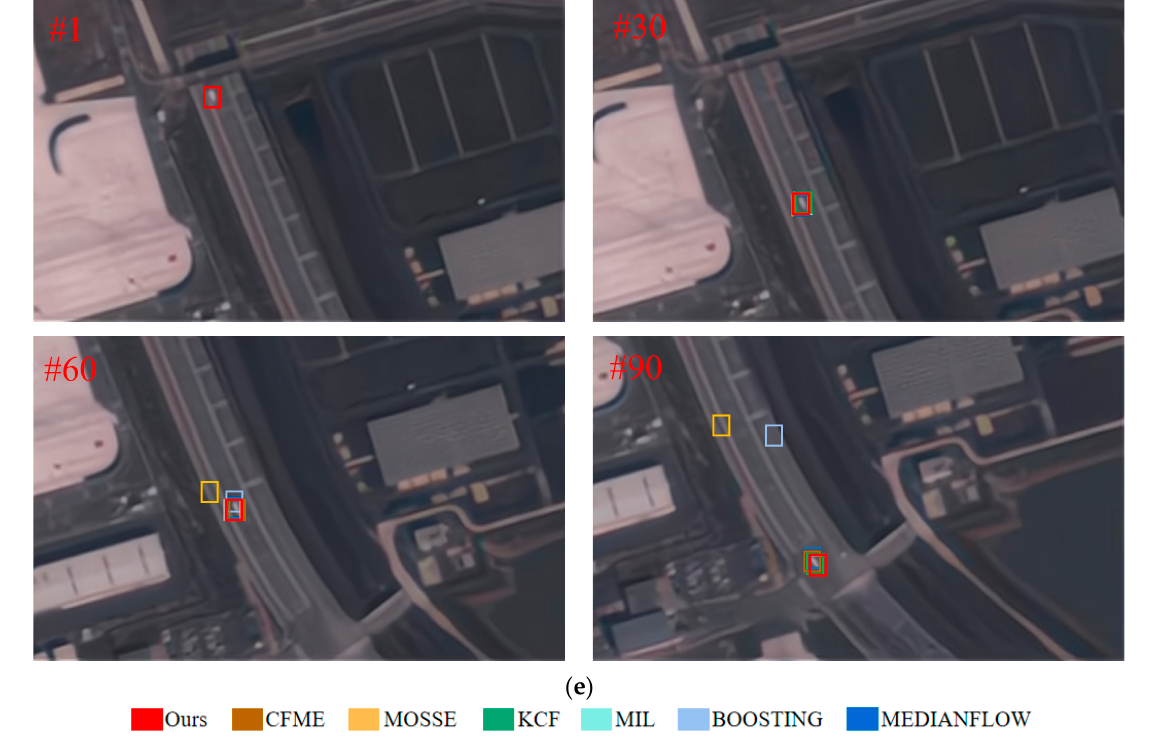
Figure 12. Visualisation of tracking results. ( a ) Visualisation of video1. ( b ) Visualisation of video2. ( c ) Visualisation of video3. ( d ) Visualisation of video4. ( e ) Visualisation of video5.